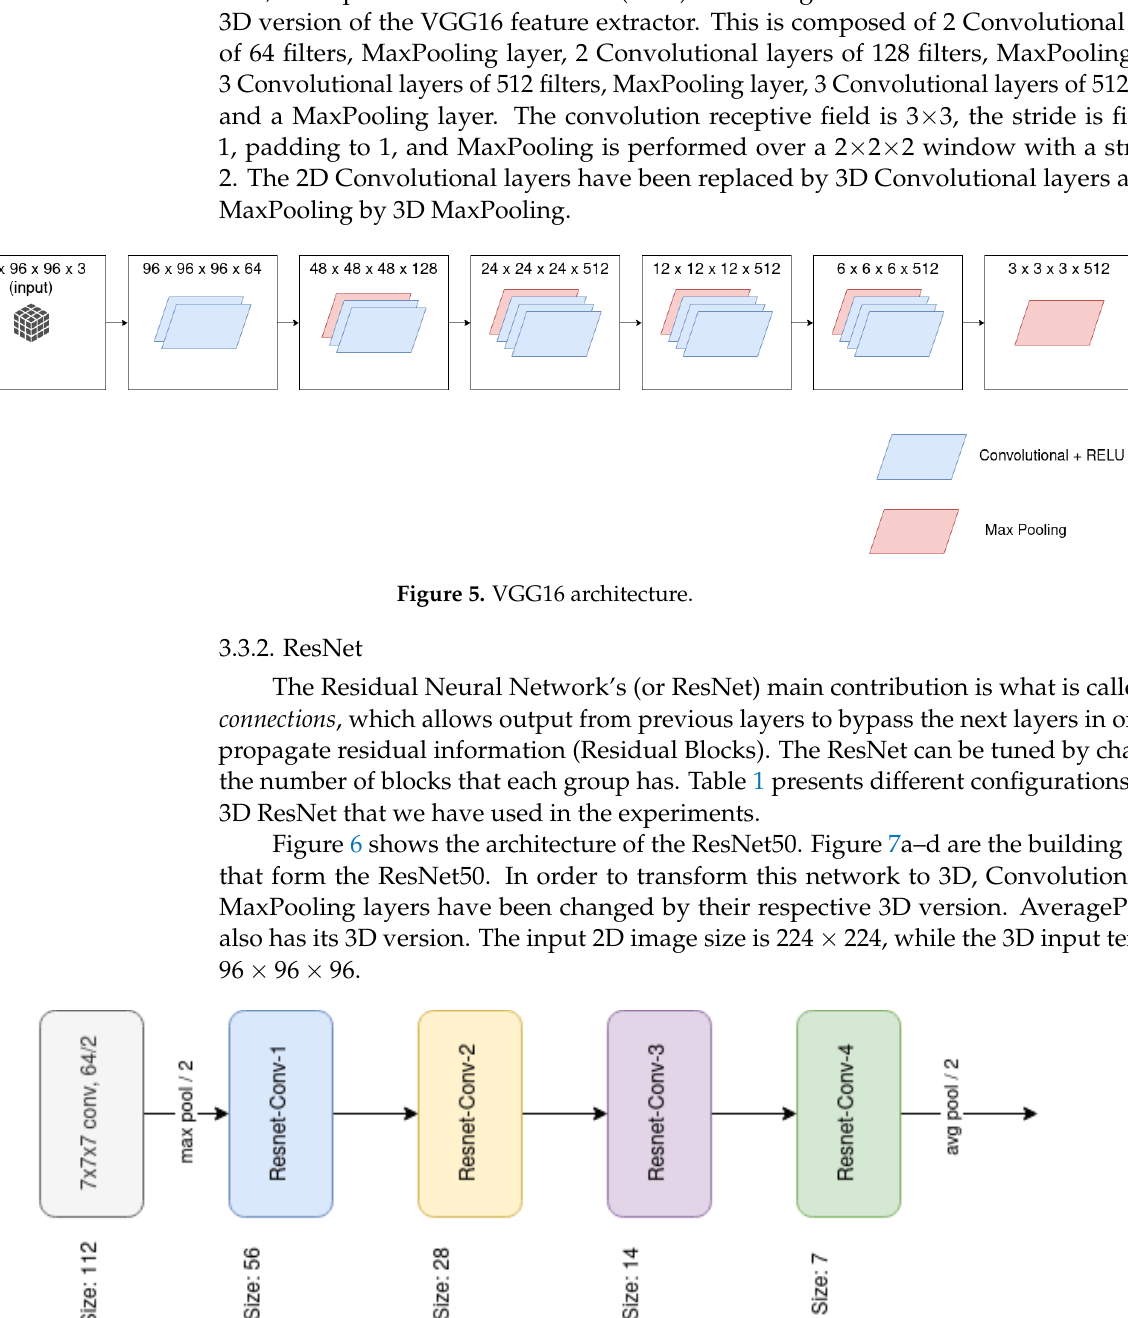
Figure 6. ResNet architecture. Building blocks are shown in